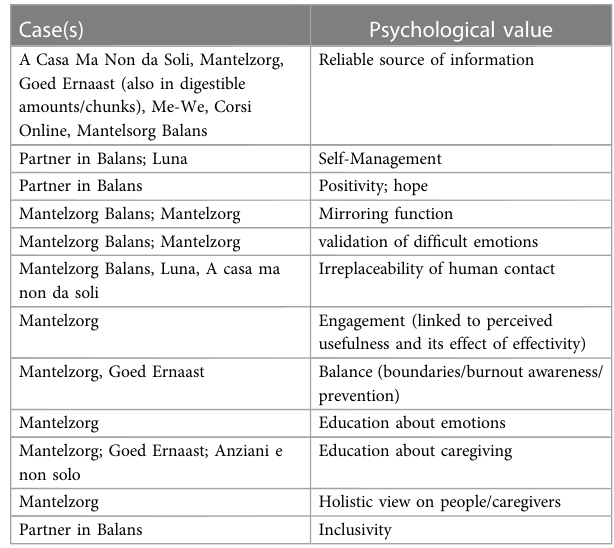
TABLE 4 Overview of psychological values.